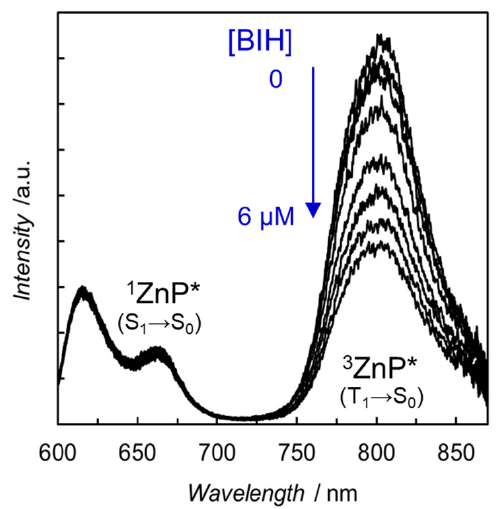
Figure 8. Emission spectra of ZnP-phen=Re in the presence of various amounts of BIH. Excited at 560 nm in Ar-saturated DMA at 298 K [43].